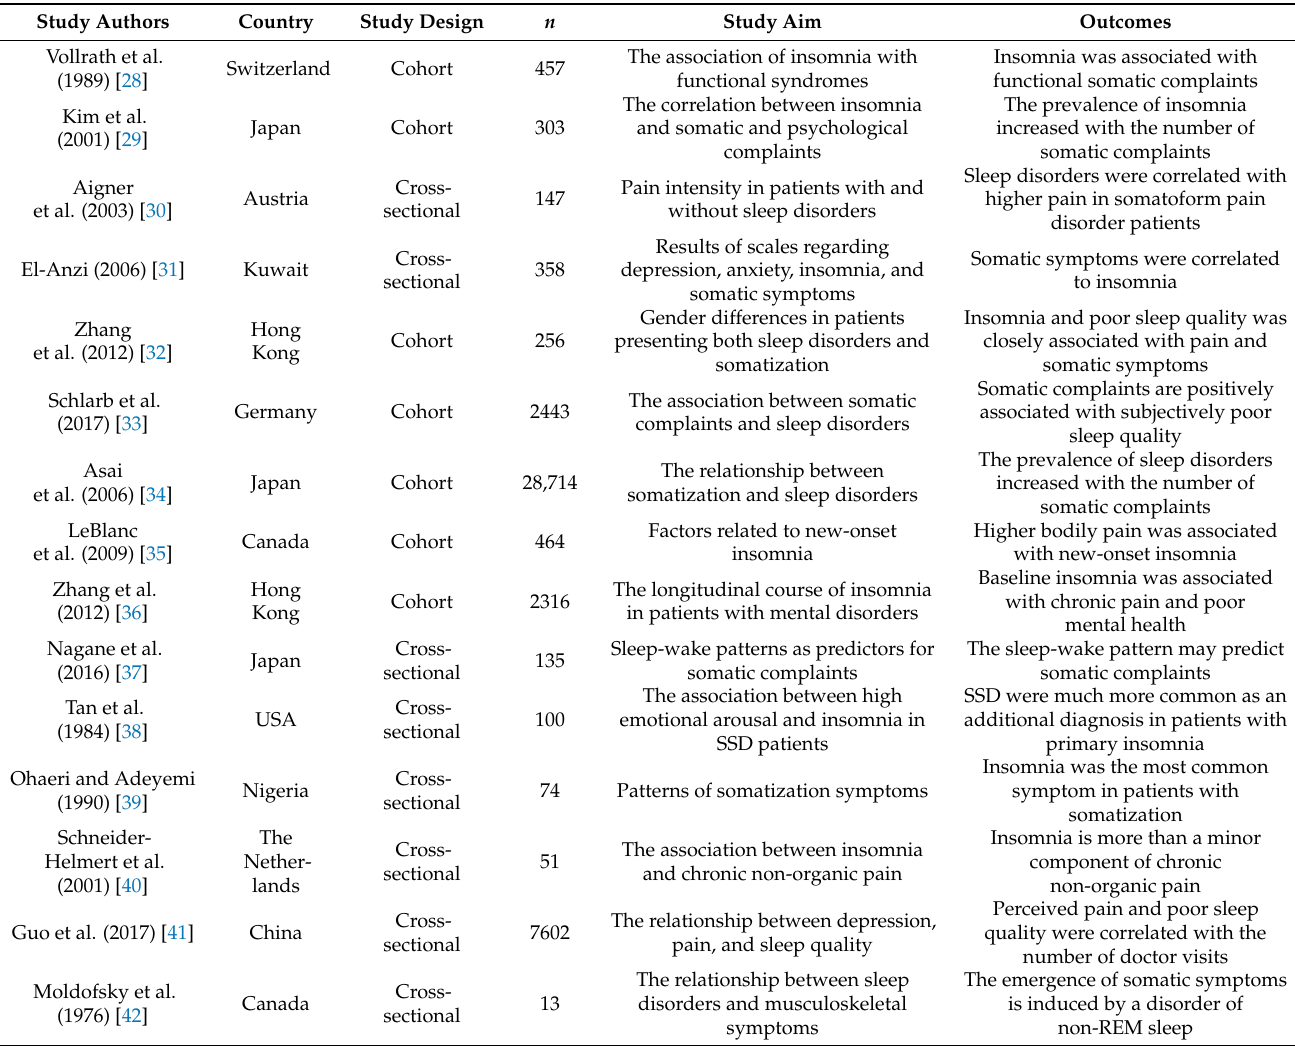
Table 1. Relationship between sleep disorders and